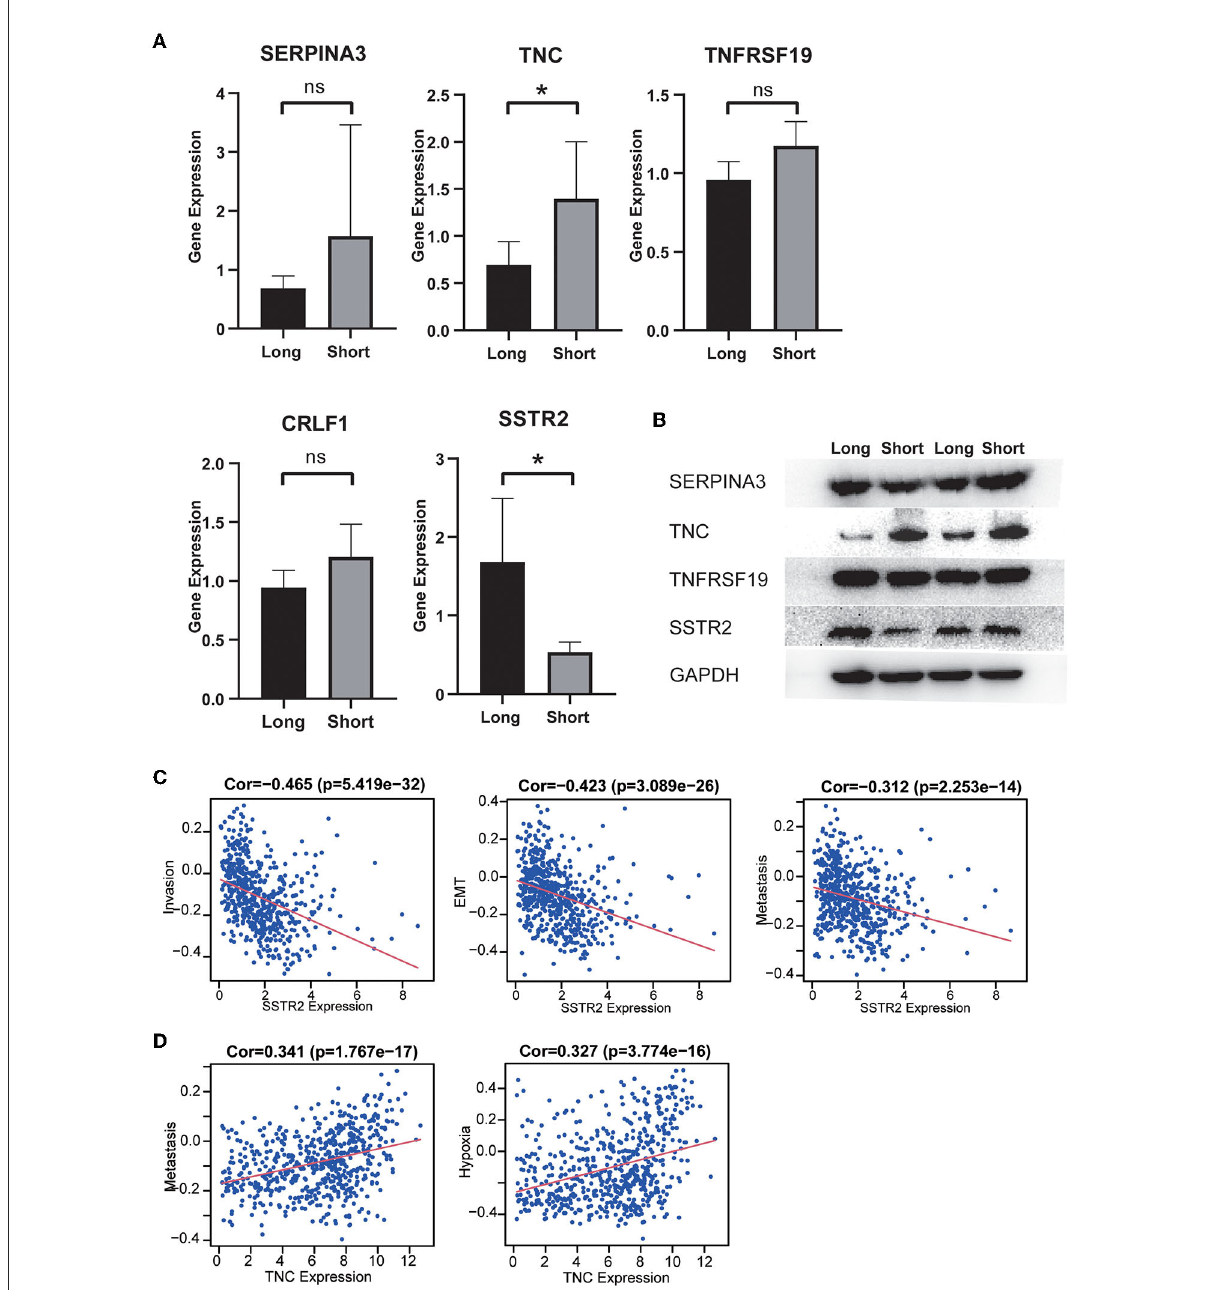
FIGURE8 (A) The expression distribution of risk score IRGs in the short-survival time group and the long-survival time group. The asterisks represent levels of significance * p < 0.05, ns: not statistically significant. (B) Western blot analysis of four differentially expressed IRGs in the signature model. The protein expression level of TNC in the short survival group was significantly upregulated, and the protein expression level of SSTR2 was significantly downregulated. There was no significant difference in the expression of SERPINA3 and TNFRSF19 between the two groups. (C) High expression of SSTR2 was negatively related to tumor invasion, EMT and metastasis. (D) High expression of TNV was positively related to tumor metastasis and hypoxia.